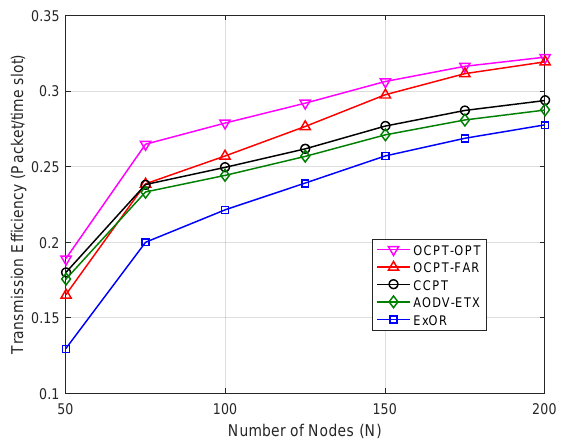
Figure 6. Transmission efficiency vs. number of nodes with different schemes under the random V s and V d